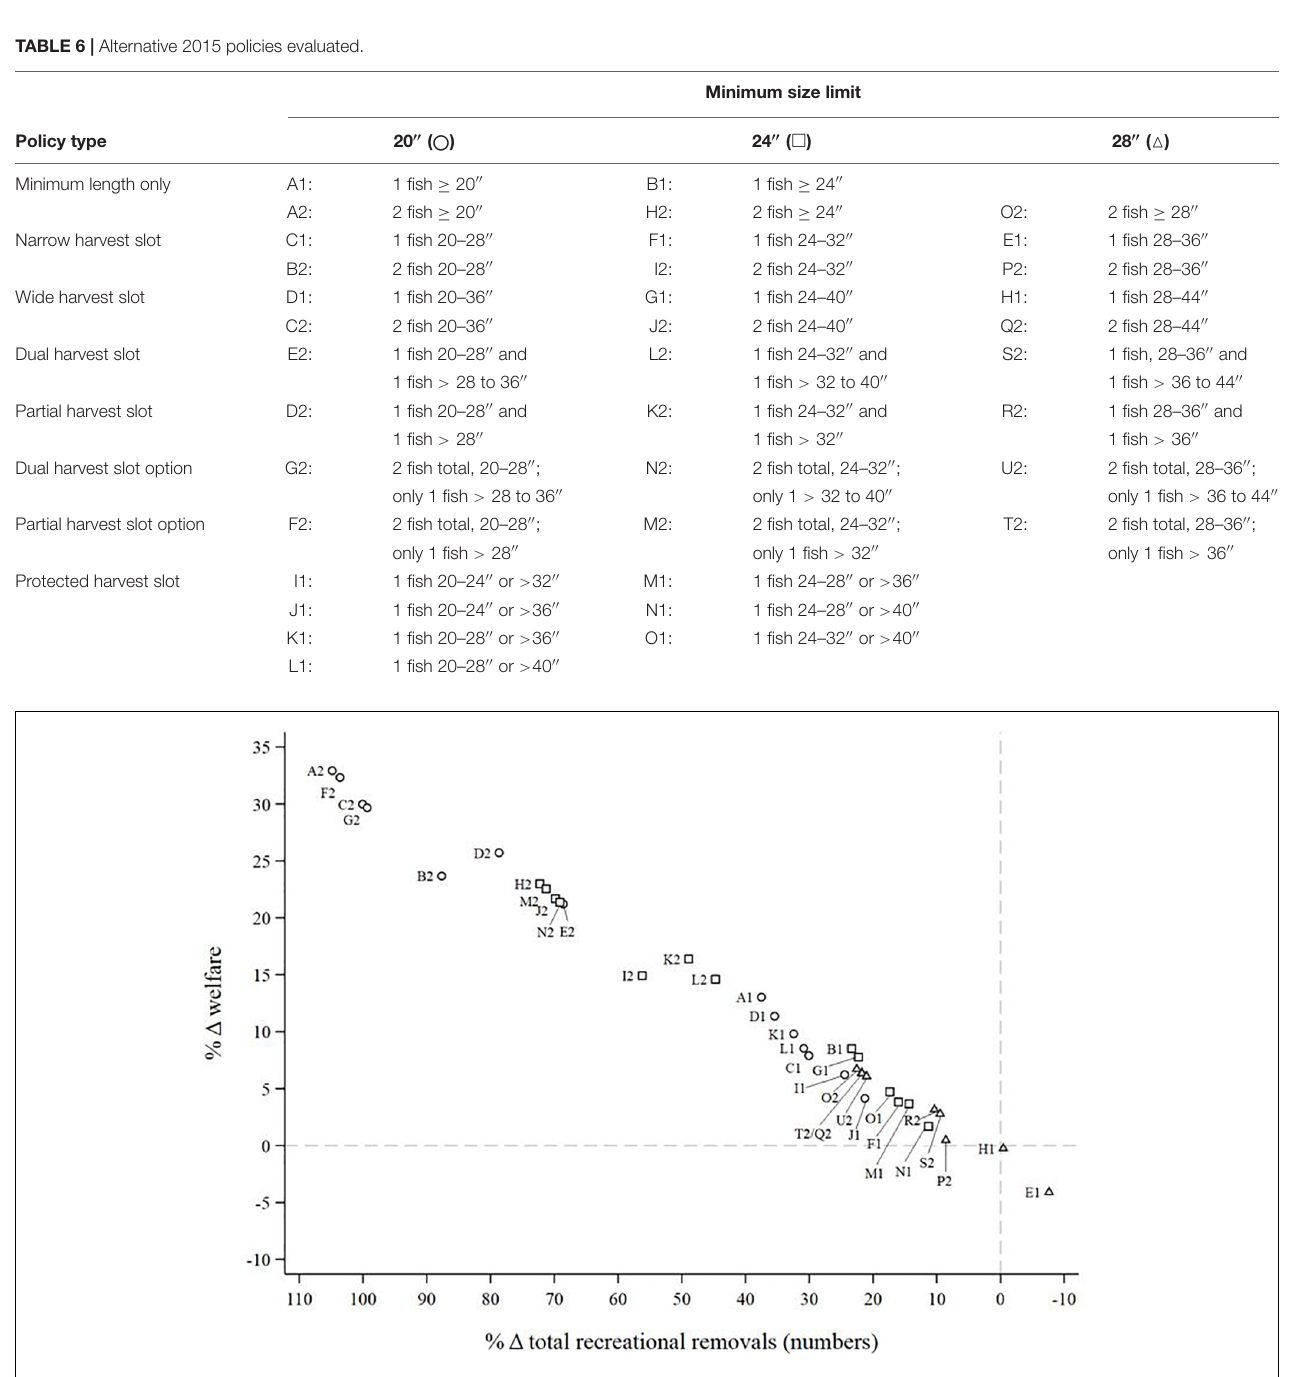
FIGURE 7 | Expected changes in welfare and total recreational removals under alternative 2015 policies in Massachusetts, Connecticut, and Rhode Island. See Table 6 for alternative policy definitions. Actual 2015 policy of one-fish, 28 (cid:48)(cid:48) or longer used as the baseline